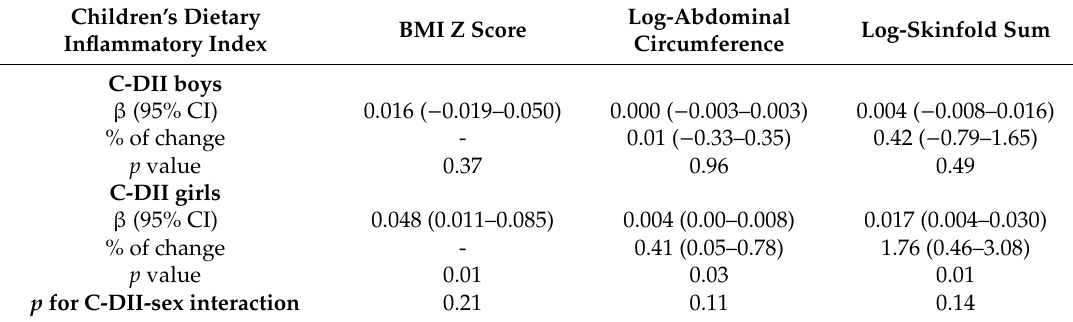
Table 1. Association between C-DII and adiposity indicators from 5–11 years 1